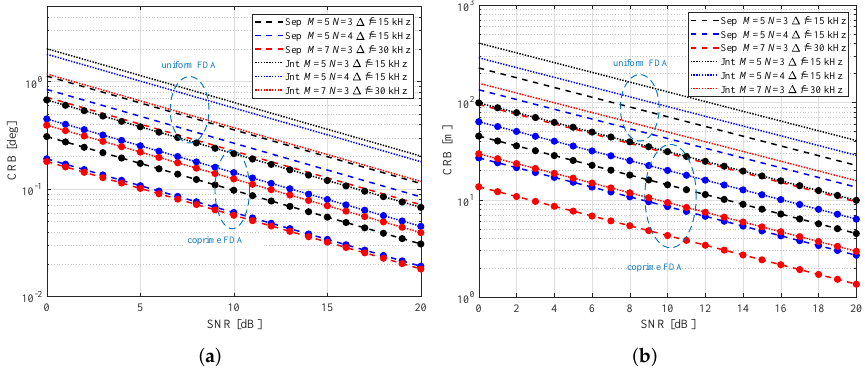
Figure 5. Influence of ∆ f on the DOA estimation performance. ( a ) ∂ CRB ( b ) ∂ SCRB and ∂ SCRB versus κ . ψ θ